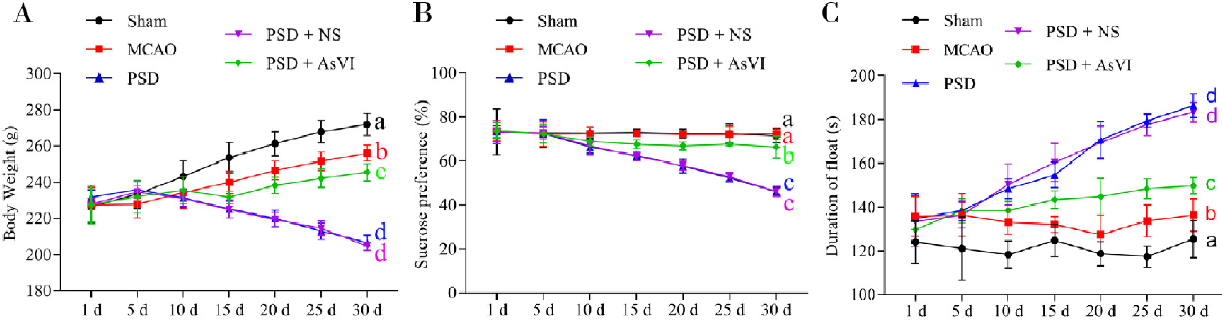
Figure 2. Effects of AsVI on immobility, sucrose preference, and body-weight loss in PSD rat model. ( A ) Dynamical fluctuations in the body weight of the rats. The body weights of rats in the PSD and PSD + NS cohort continually deceased. The body weights of rats in the sham and MCAO